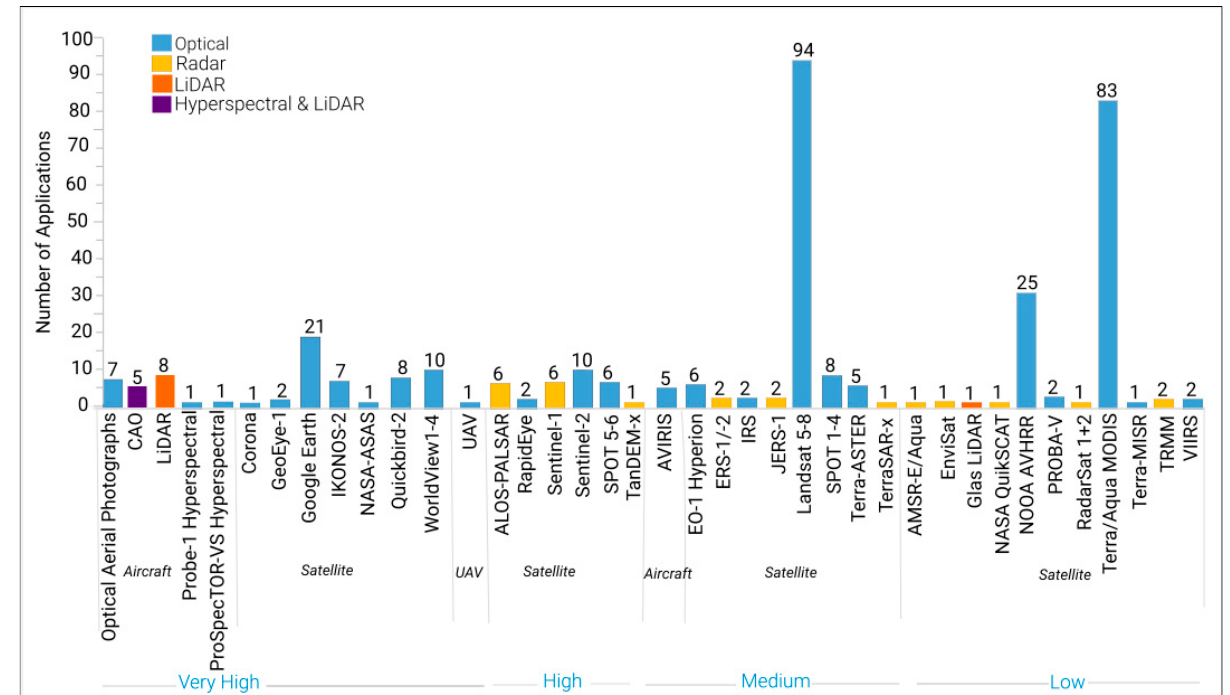
Figure 6. Count of sensor fleets and type of earth observation data mission types employed by the 197 studies, organized according to the spatial resolution (low > 30 m, medium (15 – 30 m), high (5 – 15 m and very high (<5 m). Studies were counted several times, where multiple sensors were used. UAV, Google Earth, and Optical Aerial Photographs are not necessarily sensor fleets but are included because of their importance as high and very high spatial resolution, although their missions are not re-constructible as such. The overview shows the frequency of use of different sensors, highlighting whether the data is optical, radar, LiDAR, or a combination, as well as the acquisition platforms (aircraft, satellite, or UAV).